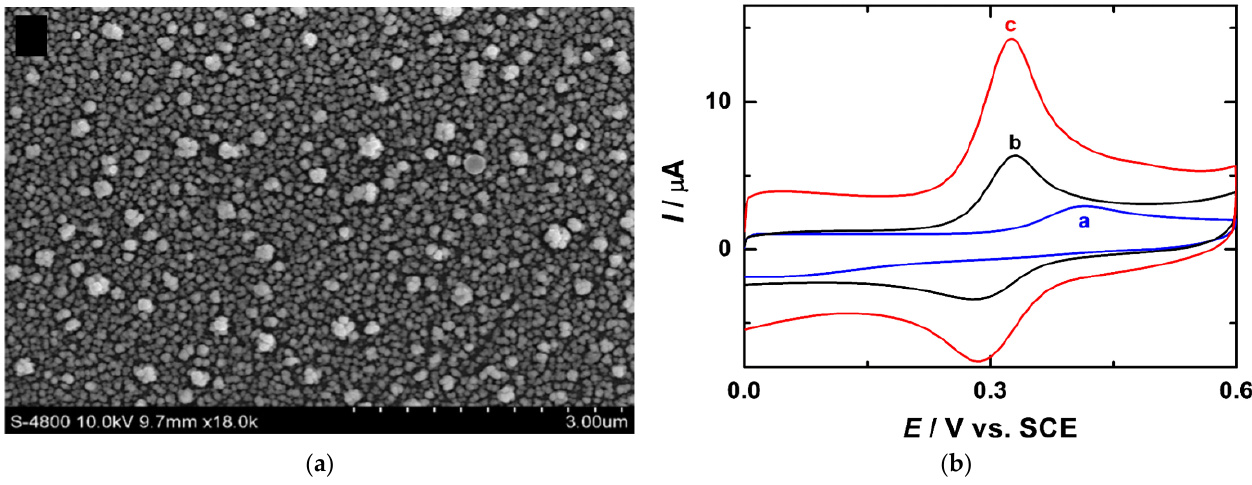
Figure 15. ( a ) SEM image of Au nanoparticles/poly(caffeic acid)/GCE; ( b ) cyclic voltammograms of 50 µM acetaminophen at bare GCE (curve a), poly(caffeic acid)/GCE (curve b), and Au nanoparticles/poly(caffeic acid)/GCE (curve c) in 0.01 M phosphate buffered saline pH 7.4. Reprinted from [89] with permission from Elsevier.